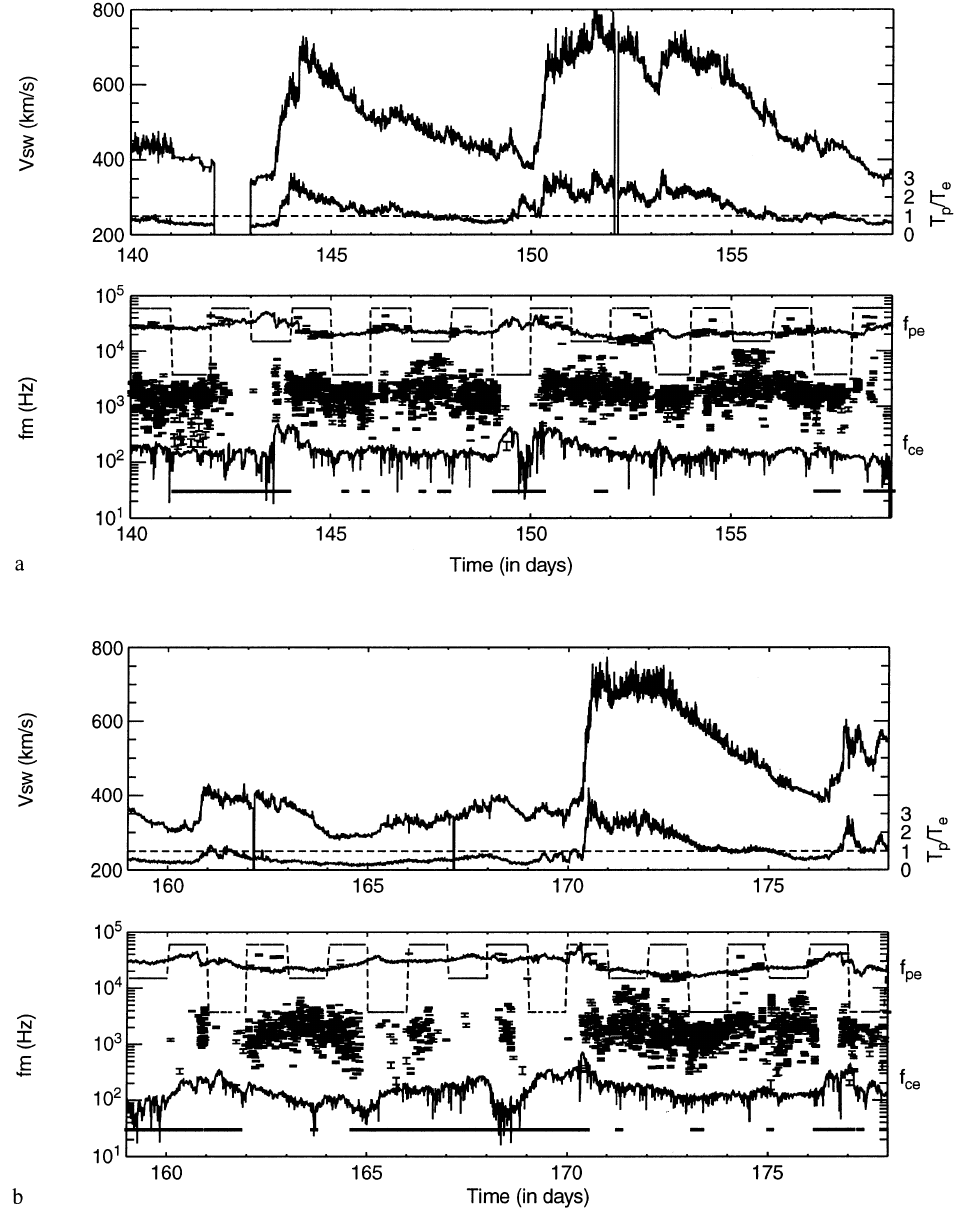
Fig. 8a, b. Synopsis of the solar wind properties and e.s. activity: a from May 20 to June 7, 1995. The numbers in abscissae indi- cate the beginning of the corre- sponding day of the year. Upper panel : V sw and T p = T e . Lower panel : each TDS event is indi- cated by a small vertical bar at its frequency f m (cid:6) 0 : 2 D f (see Eqs. 1 and 2). The characteristic frequencies f pe (3D-plasma da- ta) and f ce are also given. b The same, from June 8 to